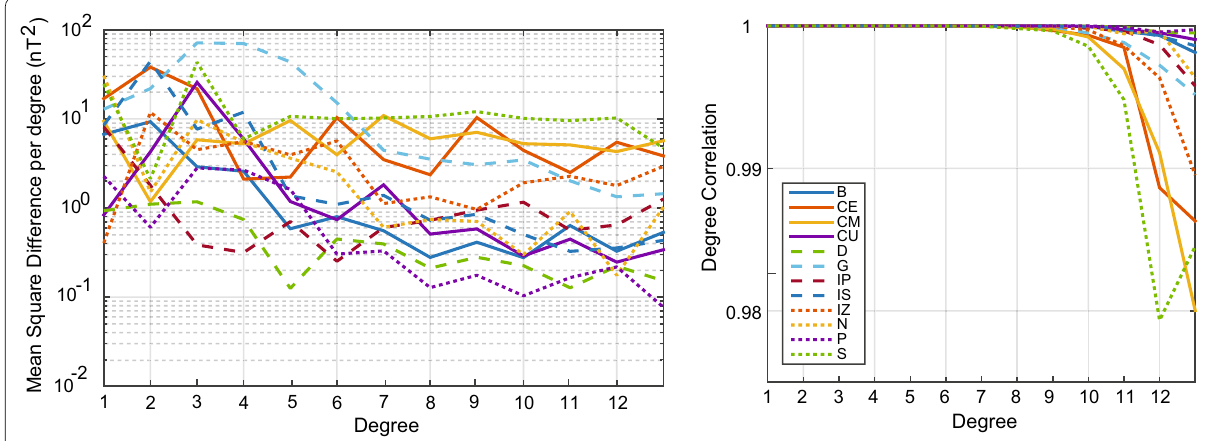
Fig. 5 Power spectral differences (left) and degree correlation (right) between the IGRF-2020 candidates and the median